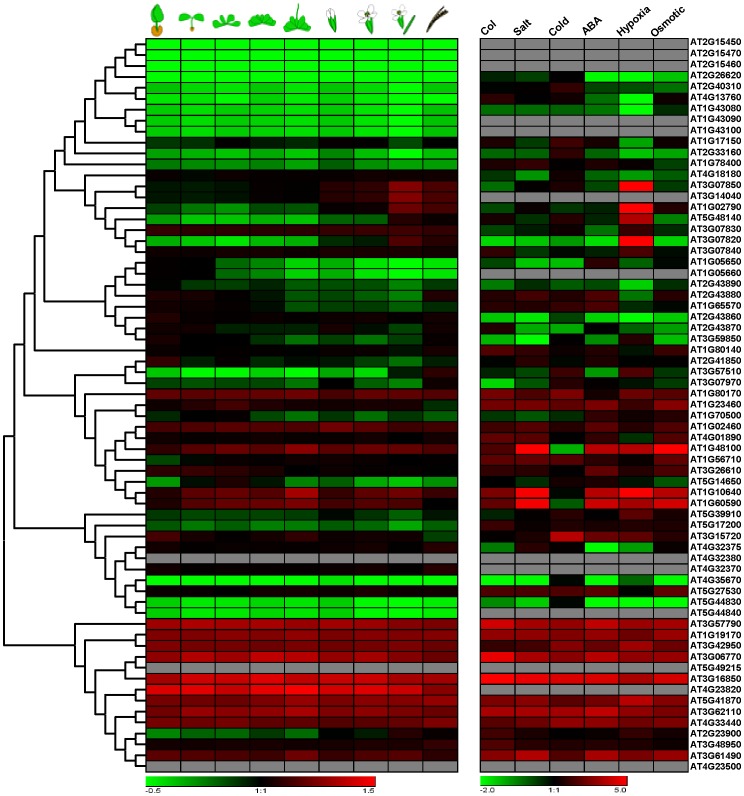
Expression profiles of the Arabidopsis pectin lyase genes.(left panel) Dynamic expression profiles of pectin lyase genes for nine different development tissues (germinated seed, seedling, young rosette, developed rosette, bolting, young flower, developed flower, flowers and siliques, and mature siliques). Expression patterns of pectin lyase genes under several abiotic stresses are shown in the right panel.